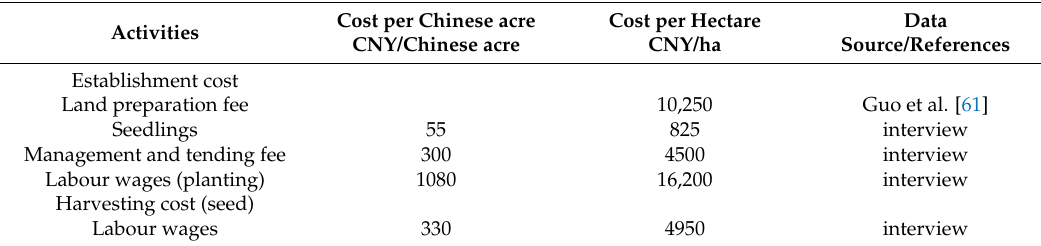
Table A3. The table of costs of the LEV